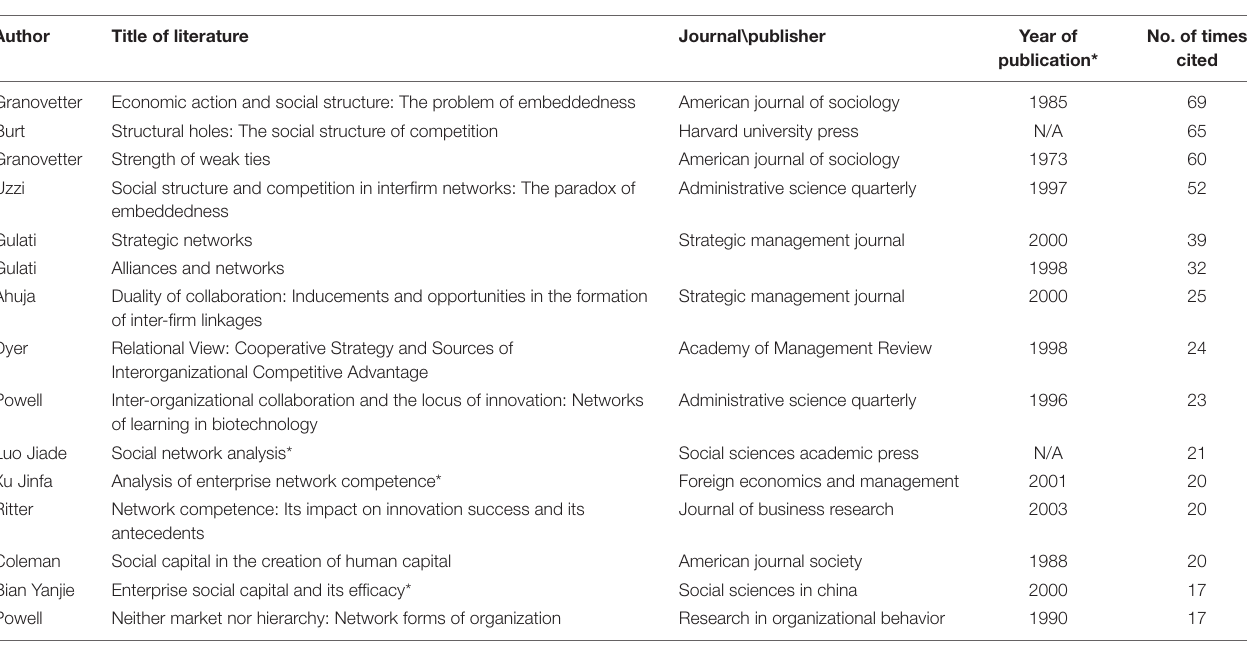
TABLE 6 | List of literature with high frequency of